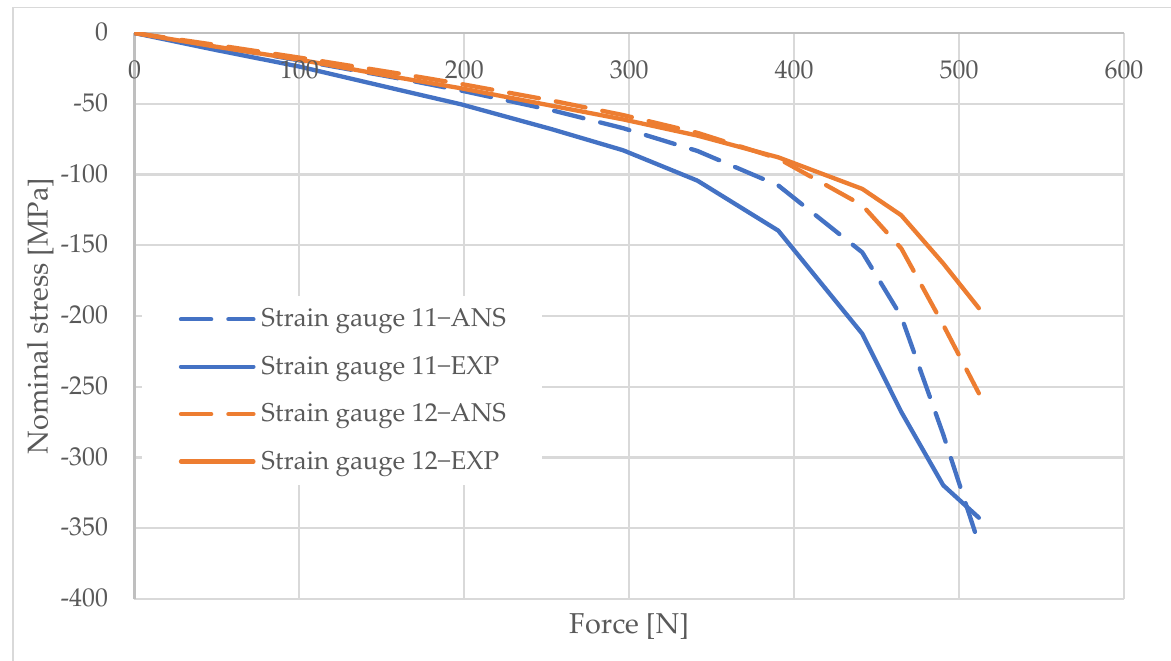
Figure 12. Pole 5/3 — values of normal stress readings from strain gauges no. 1, 4, and 7.